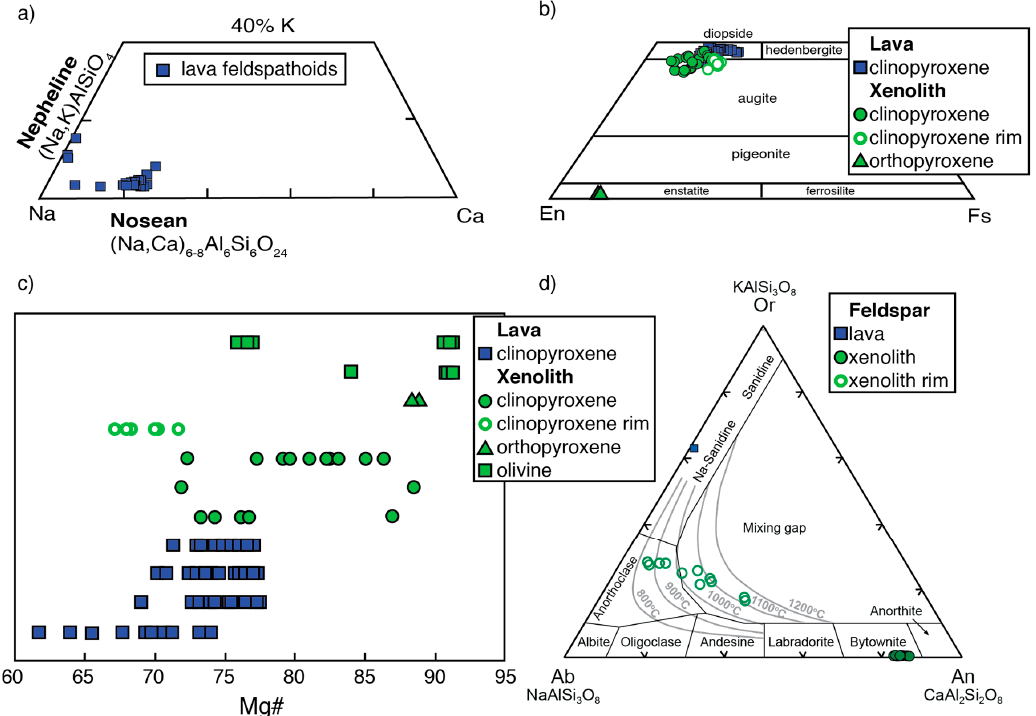
Figure 3. Mineral chemistry classification: ( a ) The feldspathoids found in the lavas classify as nosean and nepheline; ( b ) The lavas host diopside, whereas the xenoliths host both diopside-augite and enstatite; ( c ) Mg# for clinopyroxene in lavas and clinopyroxene, orthopyroxene and olivine in xenoliths; ( d ) Rare Na-sanidine is found in the lavas while the xenoliths are rich in anorthitic plagioclase, whereas the reaction rim is anorthoclase in composition. The ternary diagram features isotherms from [33]. Credit is given to Delta-plot for ternary plots.